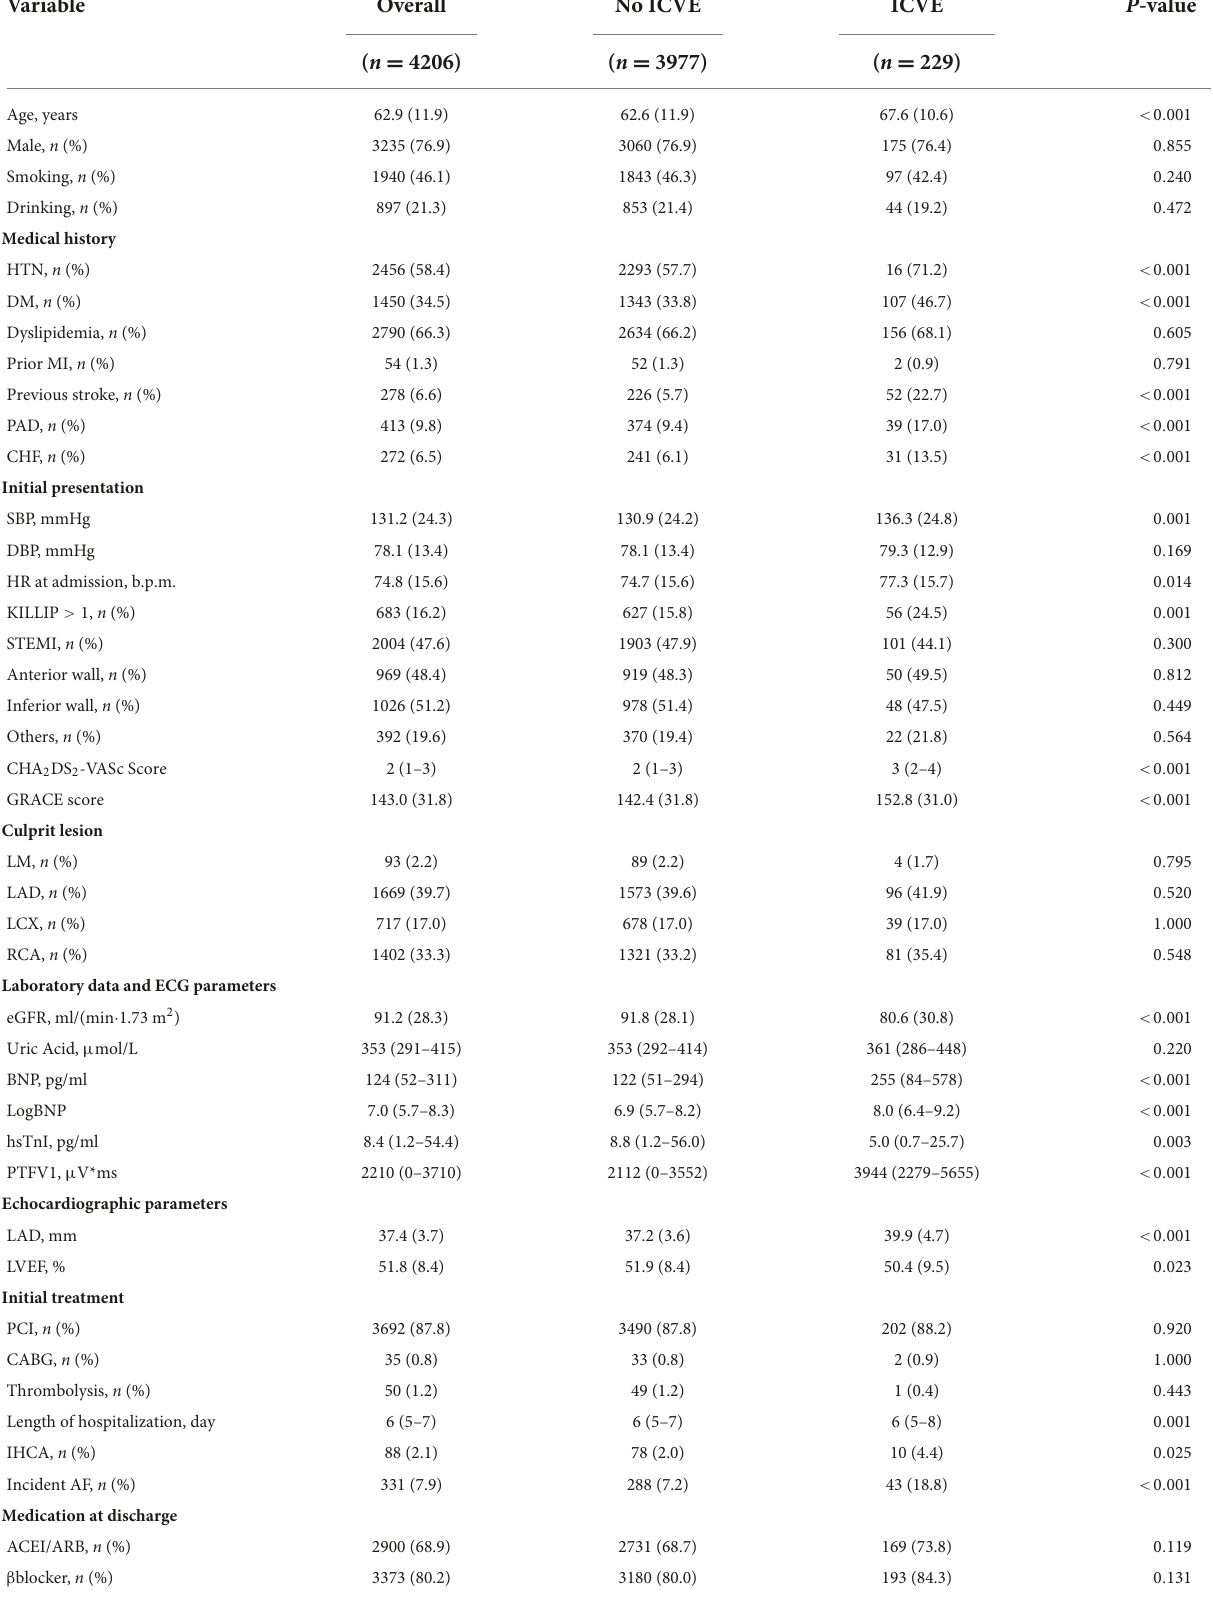
TABLE 1 Baseline